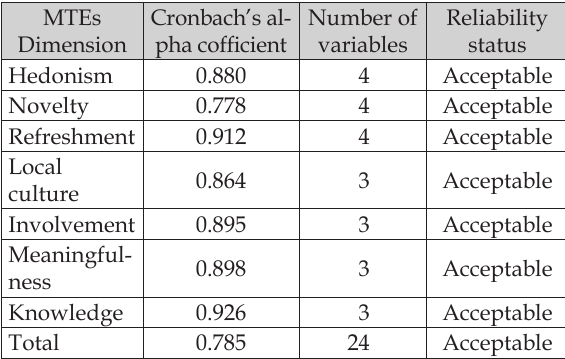
Table 2. The result of reliability of the research ques-